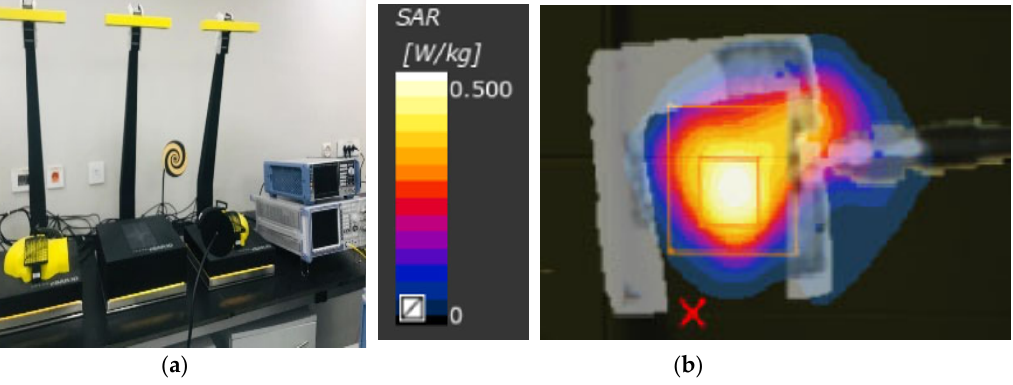
Figure 22. SAR measurements of the proposed antenna-based sensor ( a ) measurement setup and ( b ) SAR distribution of the CPMS. Table 2. Comparison of measured SAR levels for the circularly polarized monopole sensor. SAR Level for CPMS Power Level